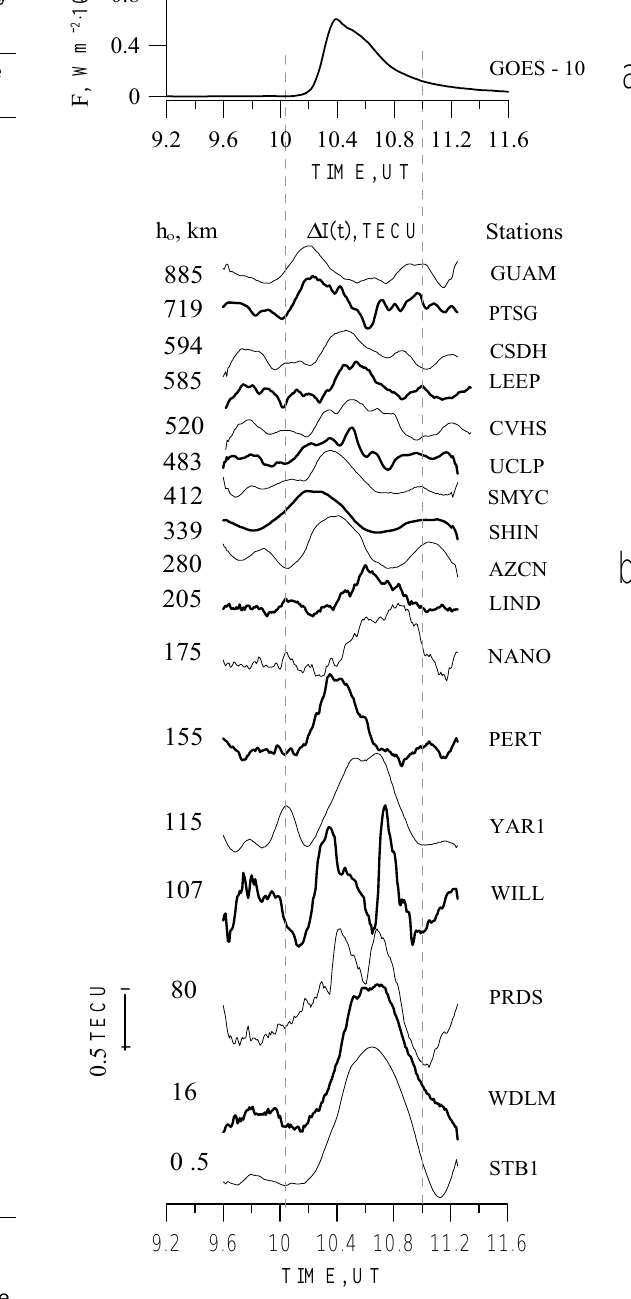
Fig. 3. Time profile of soft X-ray emission in the range 1– 8 ˚A(GOES 10 data) (a) . Examples of time dependencies of the TEC response 1I(t) for LOS intersecting the boundary of the shadow cone at different altitudes h 0 during the solar flare of 14 July 2000 (for a better visualization, the dependencies are drawn by lines of different thicknesses); the column at the left shows the values of these heights, and the column at the right shows the names of the corresponding stations (b) .